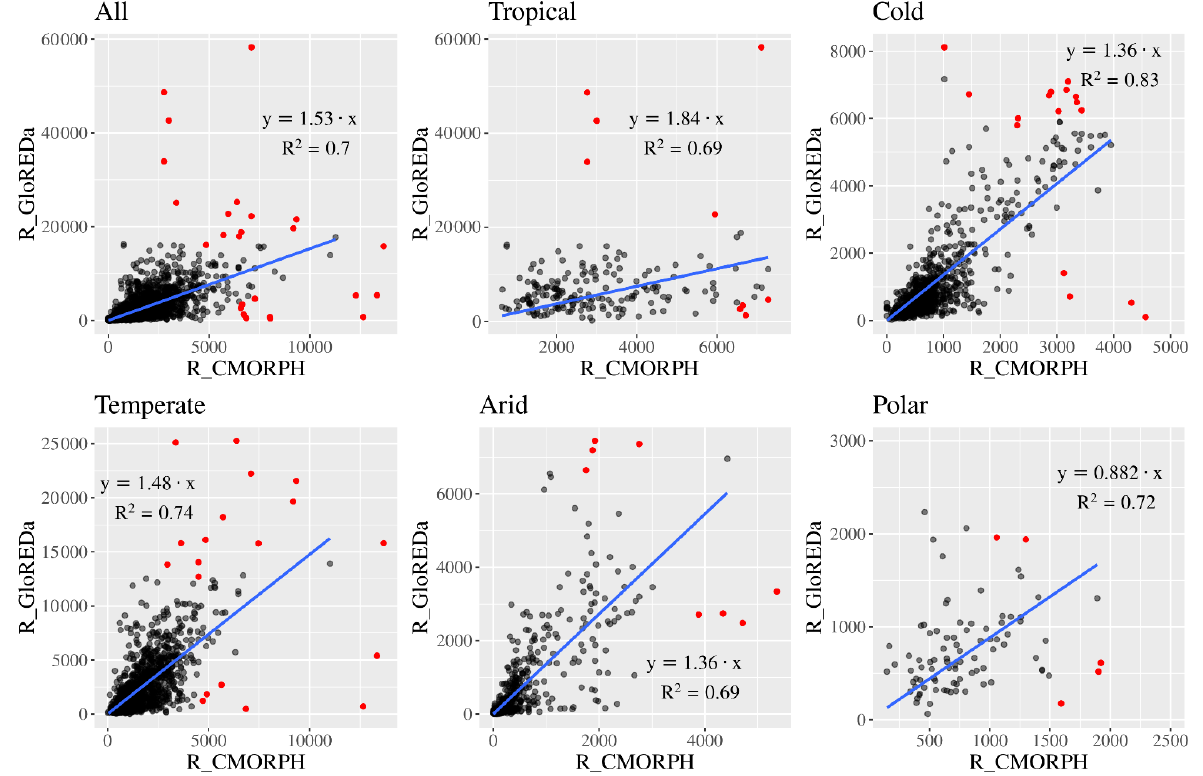
Figure 9. Comparison between CMORPH and GloREDa data sets at station scale and proposed correction factors for the whole data set and per climate zone (tropical, cold, temperate, arid, polar). Blue line indicates the linear trend. Red dots are the few outliers (i.e., identified based on Cook’s distance) excluded from the